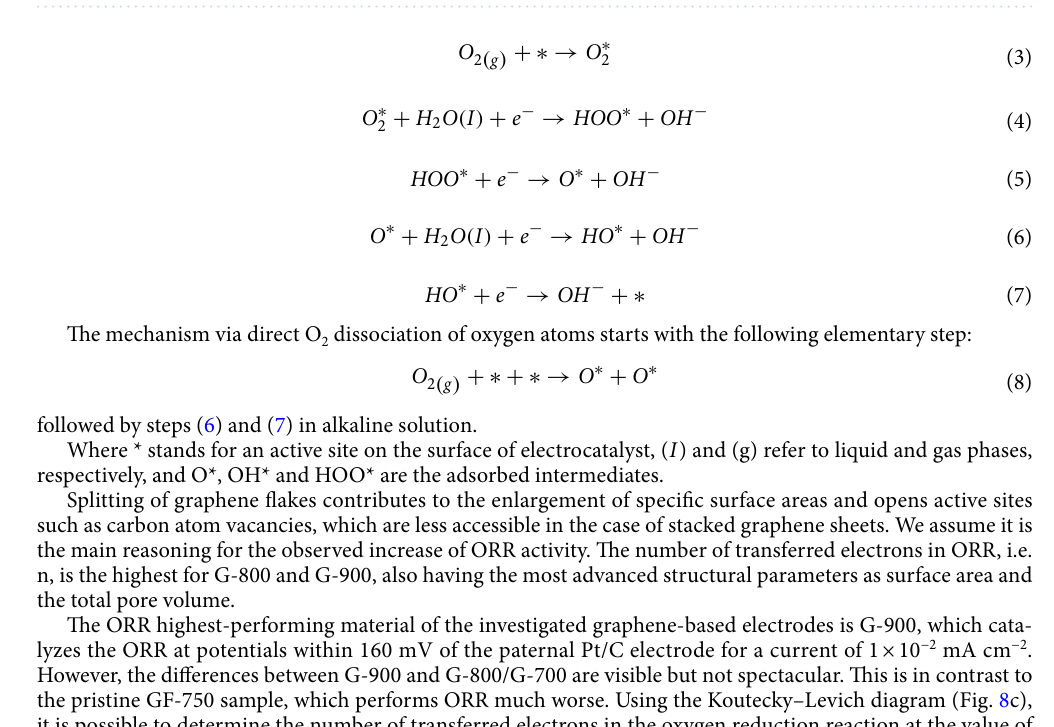
Figure 7. High-resolution X-ray photoelectron spectra for O1s of all investigated samples: ( a ) O1s of GF-750, ( b ) O1s of G-700, ( c ) O1s of G-800, and ( d ) O1s of